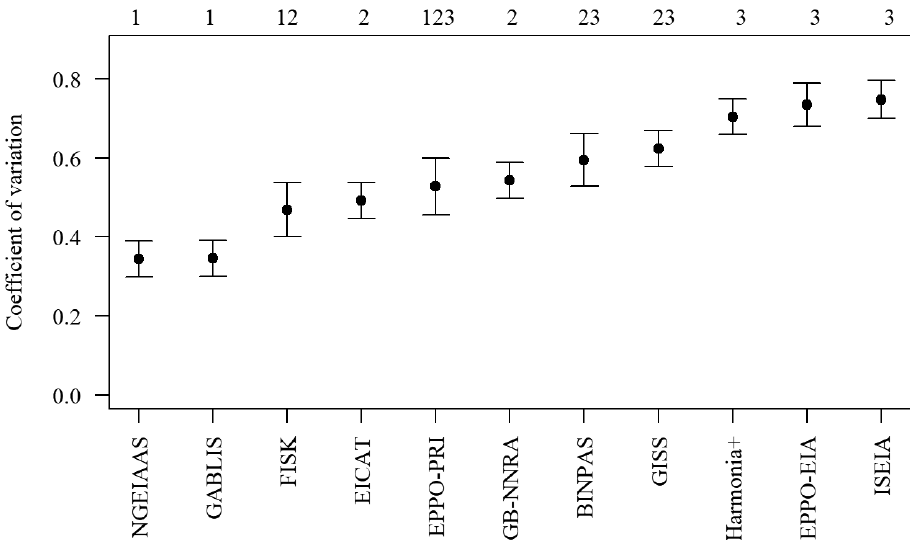
Figure 1. Coefficient of variation (CV) of species scoring across assessors per impact assessment protocol based on linear mixed models controlling for taxonomic group and species as nested random effects and number of assessments per species as fixed effects. Protocols with the same letters above the graph are not significantly different ( p < 0.05; Tukey test). Dots indicate the least squares means per protocol. Lines indicate the confidence interval (95%) around the